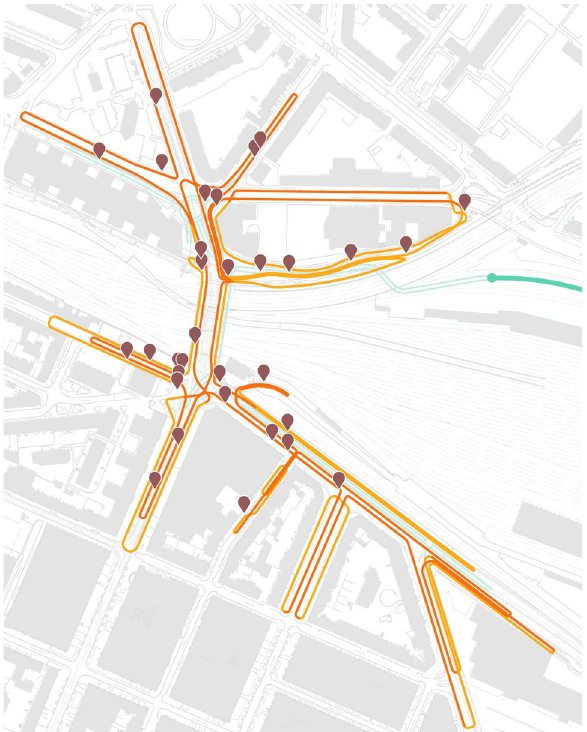
Figure 8. Mobile mapping campaigns with the BIMAGE backpack: vehicle-based acquisition along the roads (orange trajectories) and along footpaths and sidewalks (yellow trajectories). GNSS control and check points are shown as red markers.